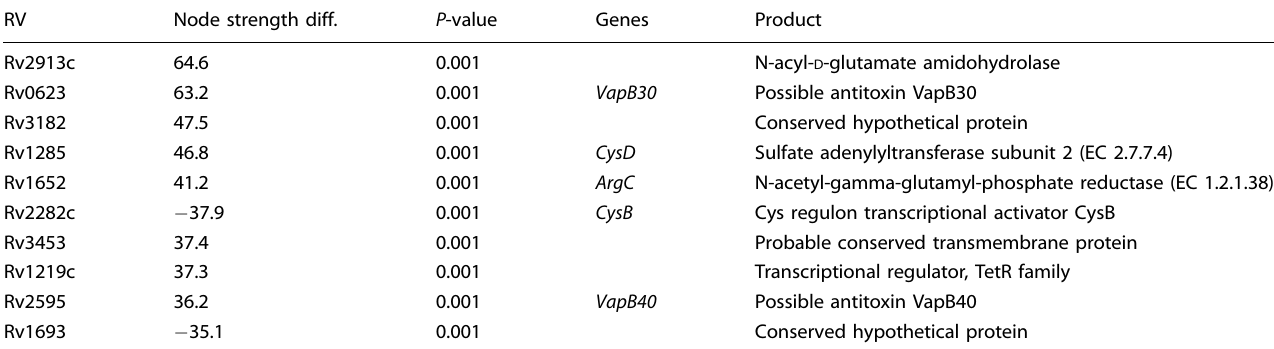
Table 2. Top ten genes ranked by absolute change in node strength between inhibitor and control networks. P -values are calculated from permutations (see “ Methods ” ). RV Node strength